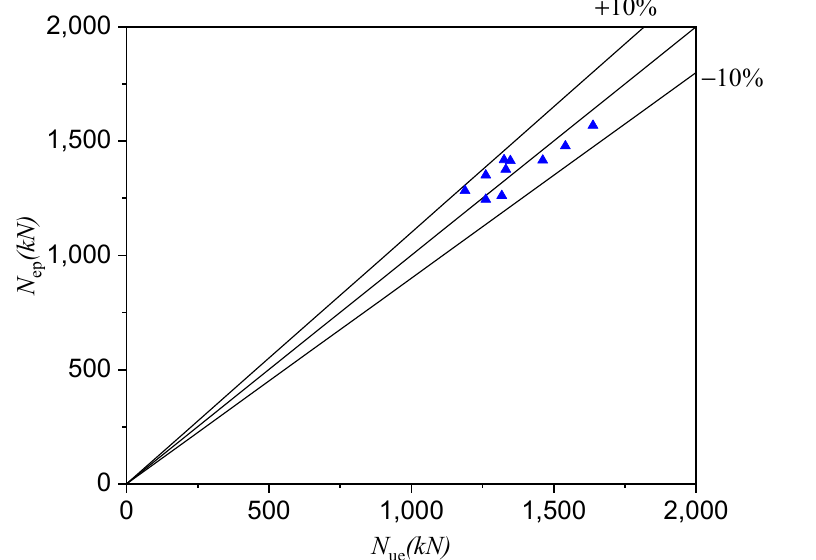
Figure 14. Comparison between the FEA results and the test results of the ultimate strength of CFST columns with different stiffeners.